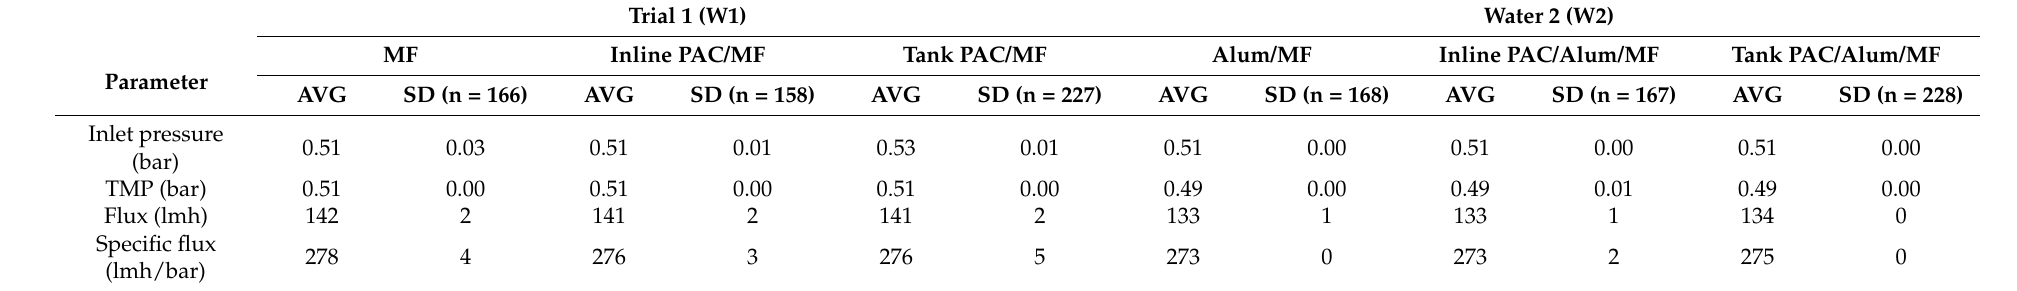
Table 4. Performances of (Alum)/MF and PAC/(Alum)/MF with tank and inline PAC dosing configurations (AVG—average values, SD—standard deviation and n—number of